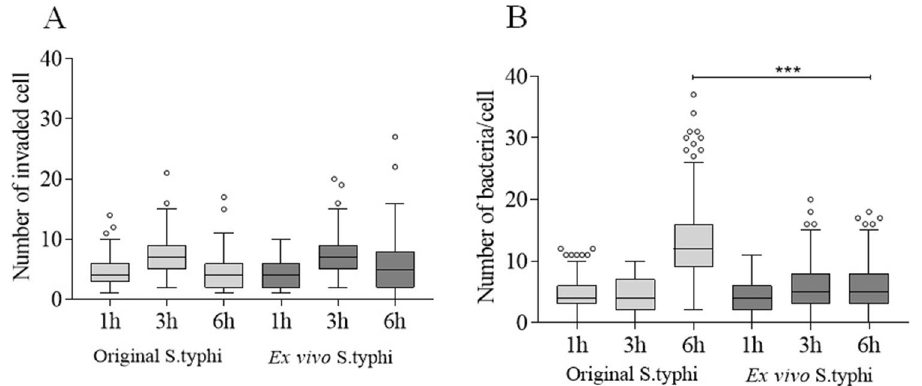
Figure 4. Comparison of the invasive capacity of pre-inoculum and ex vivo obtained bacteria. HeLa cell invasion assay to evaluate the possibility of ex vivo Salmonella having its phagocytic activity influenced by some modulation due to host response. ( A ) Number of cells invaded and ( B ) number of bacteria per cell between aliquots of S_Typhi strain used in pre-inoculum conditions with ex vivo strain obtained from liver macerate. Pre-inoculum aliquot was obtained after growth of nine hours in LB broth and stored at − 80 °C for more than 15 days until the moment of the assay. The ex vivo aliquot was obtained from a macerated mouse liver coinfected on D4 and frozen at − 80 °C. The two ex vivo and pre-inoculum bacteria were thawed and set for invasion assay in HeLa cells. Pre-inoculum bacteria were diluted in a series of 10–10 and sown in SS-Agar medium to define the inoculum equivalence of ex vivo bacteria. The invasion time was 1, 3 and 6 h. After these periods, medium supplemented with gentamicin was added to the culture medium for 1 h in order to eliminate external bacteria. Slides were then washed, stained using the Romanowsky method and bacteria visualized. The data are shown in a box plot with mean and standard deviations. Asterisks: level of significance of * p < 0.05, ** p < 0.005 and *** p <